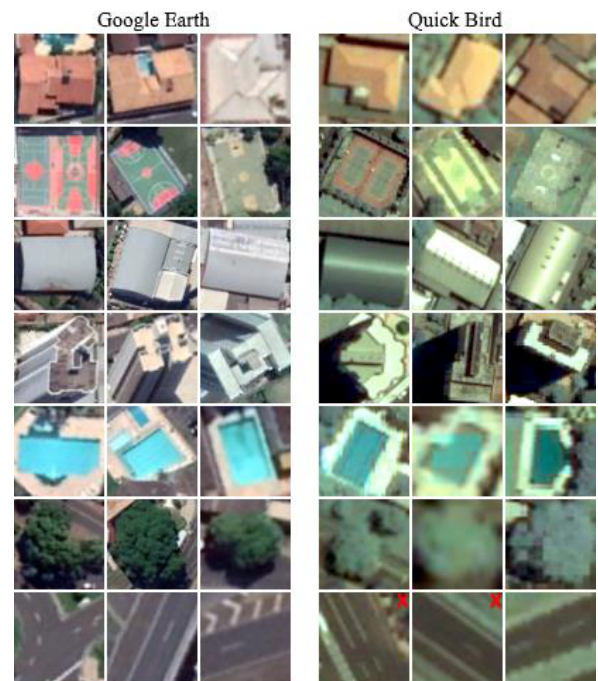
Figure 7 – External validation of the CNN training using Google Earth and Quick Bird images. The ‘x’ mark in red indicates